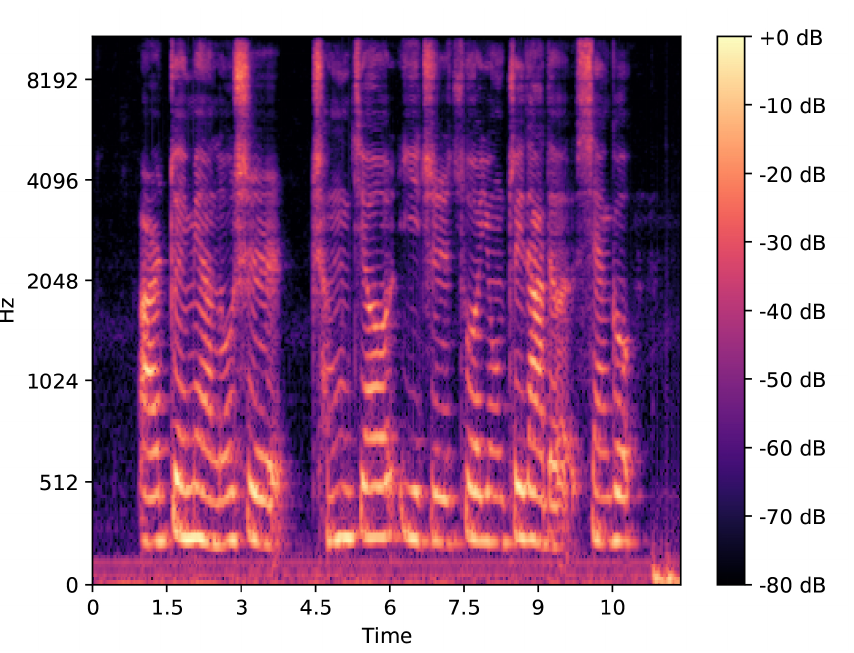
Figure 6. Spectrogram of speech. The intensity of any given frequency component at a given time is expressed by color depth. Darker, smaller; brighter, larger.